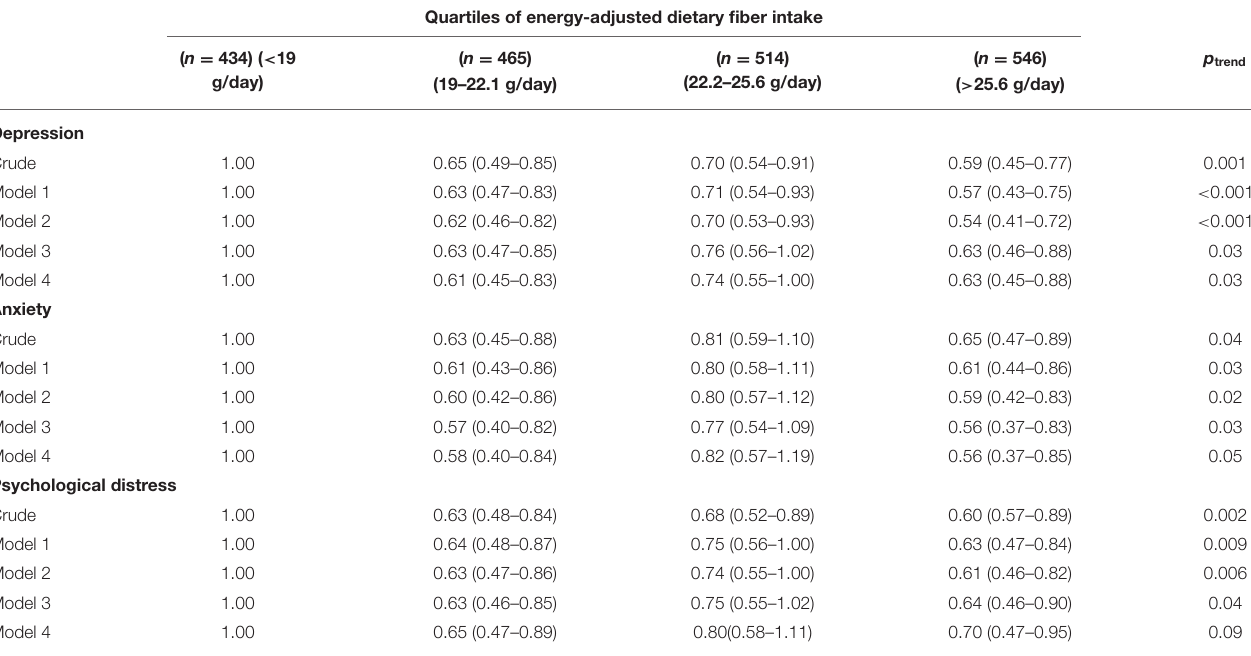
TABLE 5 | Multivariable-adjusted odds ratios and 95% confidence intervals for depression, anxiety, and high psychological distress across quartiles of energy-adjusted dietary fiber intake in women ( n = 1,959) a . Quartiles of energy-adjusted dietary fiber